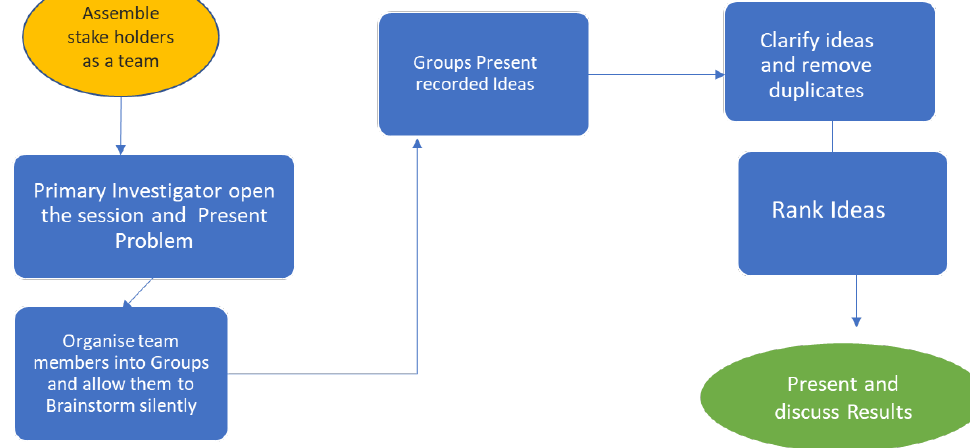
Figure 1. Nominal Group Technique (NGT) session to identify training related challenges with the delivery of quality point of care